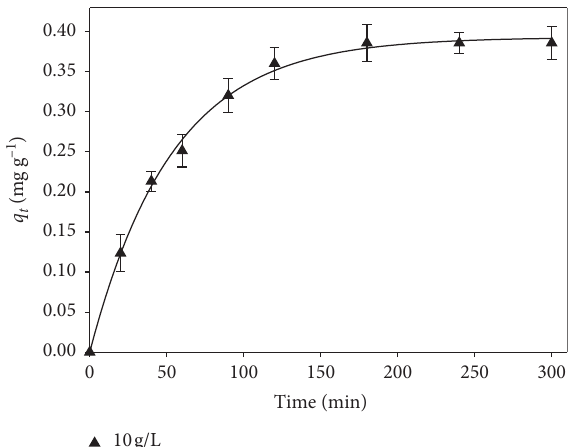
Figure 2: Adsorption of acid red 73 on rice wine lees as a function of contact time.